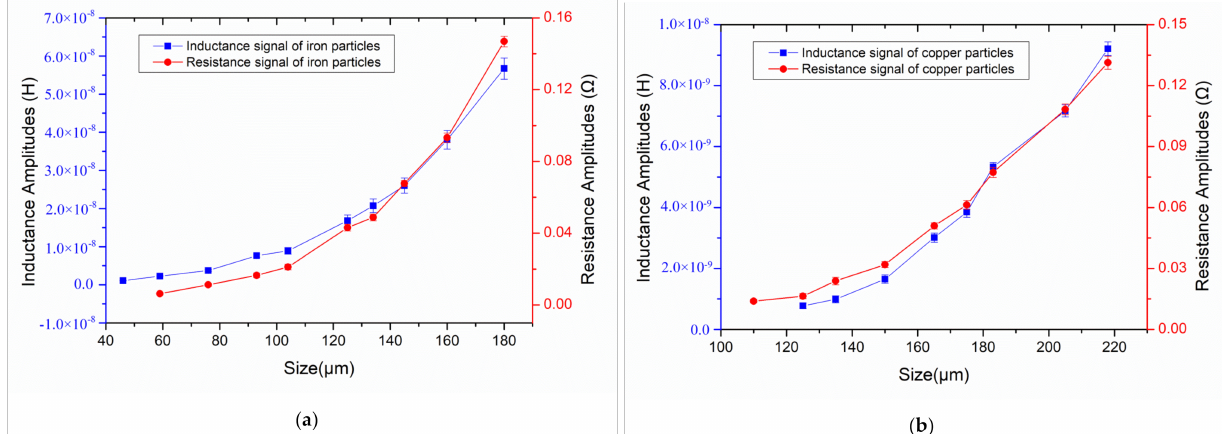
Figure 9. The inductance pulse amplitudes and the resistance pulse amplitudes of metal particles with different diameters. ( a ) detection results of iron particles; ( b ) detection results of copper